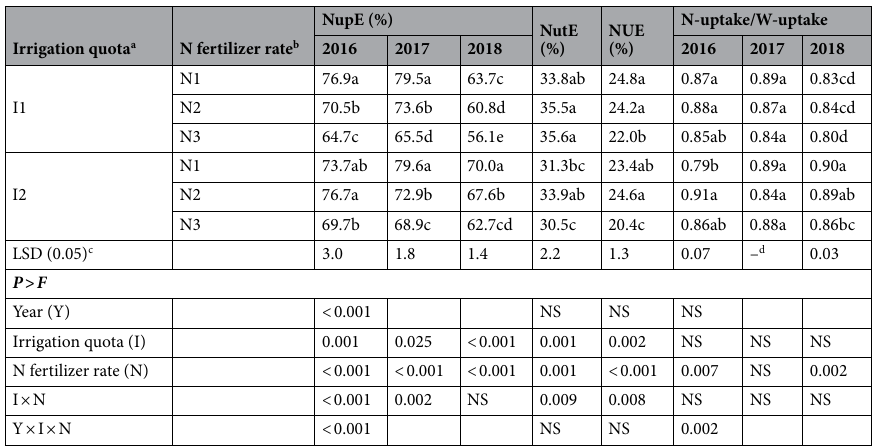
Table 4. Nitrogen uptake efficiency (NupE), N utilization efficiency (NutE), N productivity (NUE), and the ratio of N uptake to water uptake (N-uptake/W-uptake) of spring wheat during the growing season as affected by irrigation quota and N fertilizer rate in 2016–2018. a I1 and I2 represent irrigation amount at 192 and 240 mm, respectively. b N1, N2, and N3 represent an N fertilizer rate of 135, 180, and 225 kg N ha −1 , respectively. c The LSD (0.05) and the P > F were for all the treatments in the same column, and means with different letters in the same column are significantly different at P < 0.05. d LSD not provided when the corresponding P > F from analysis of variance is not significant at P ≤